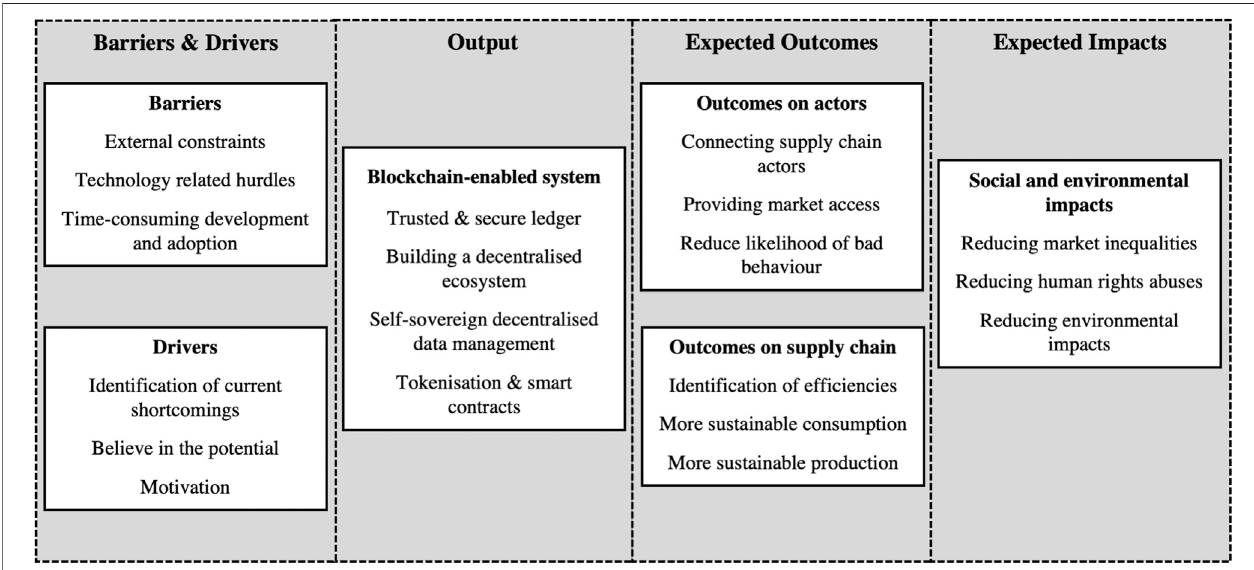
FIGURE 2 | Outputs, outcomes, impacts, and factors in fl uencing blockchain-enabled systems. The grey columns resemble a pressures, practices, and performance framework (Choudhary and Sangwan, 2018) where barriers and drivers represent pressures, the output is the practice, and outcomes and impacts are performance. The columns for practice and performance also illustrate an output, outcomes, and impacts approach (Koontz et al., 2020). The output is the decision taken to implement a blockchain-enabled system. The outcomes are the changes directly resulting from the output. The social and environmental impacts are changesonhumanwellbeingandecosystemwellbeing — includingreductionsofexistingissues.Thewhiteboxesrepresentdimensions.Thebulletpointssummarisethe themes.